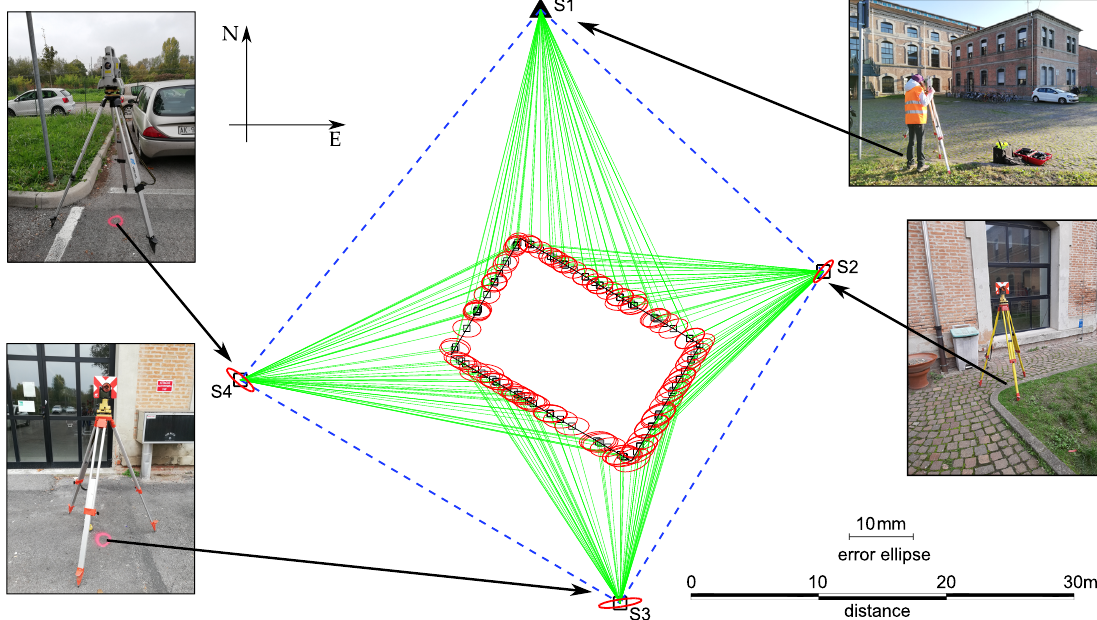
Figure 4. Scheme of the network and error ellipses of benchmarks and